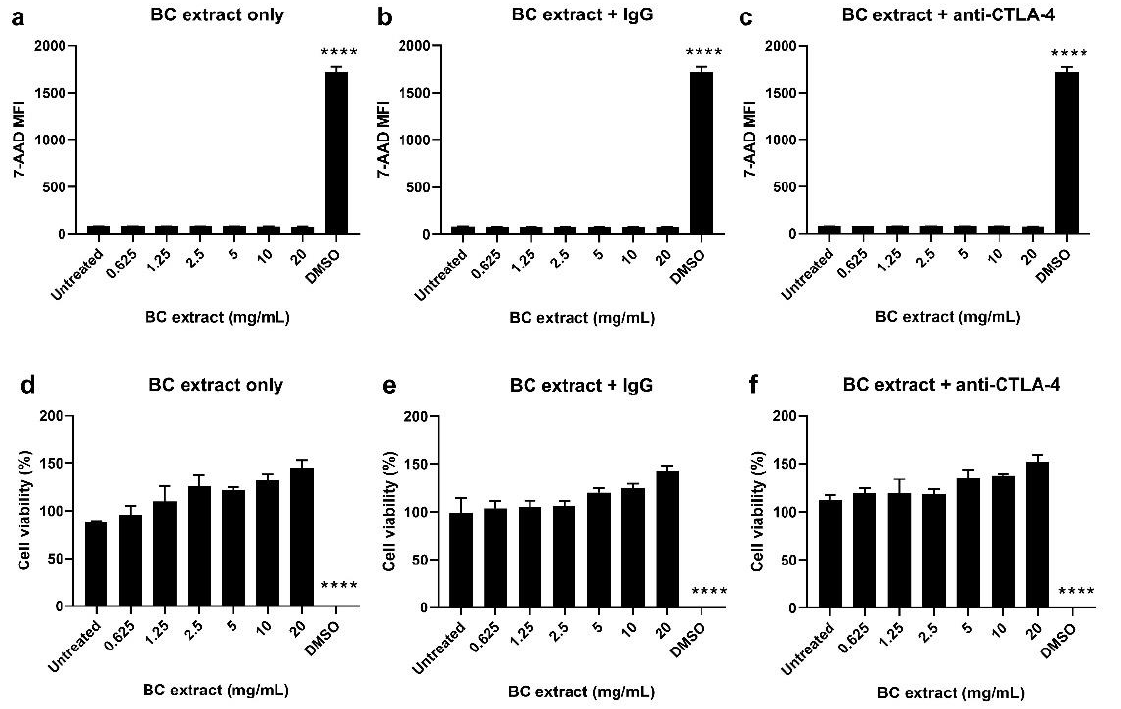
Figure 3. Cytotoxicity evaluation of BC extracts in MC38 tumor cells with 7-AAD staining and MTS. BC extracts were prepared by dissolving 1 g of BC in 50 mL culture medium, which yielded an extraction ratio of 20 mg/mL. Empty extracts or extracts supplied with human IgG or anti-CTLA-4 (both starting at a concentration of 50 µg/mL) were tested on MC38 cells. DMSO was used as posi- tive cell killing control. The primary measure was cell viability, which was assessed by 7-AAD stain- ing (live-dead cells exclusion marker; figures a – c ). Higher 7-AAD MFI signal is a hallmark of dying cells with leaky cell membranes. Cytotoxicity was also assessed using a cell metabolism assay (MTS), in which higher cell metabolism is indicative of higher cell viability ( d – f ). Cell metabolism was measured 48 h after incubation. All data are shown as mean ± SD for triplicates. Only the DMSO treatment significantly decreased cell viability, which was assessed with a Student’s t test, with **** denoting p < 0.0001.